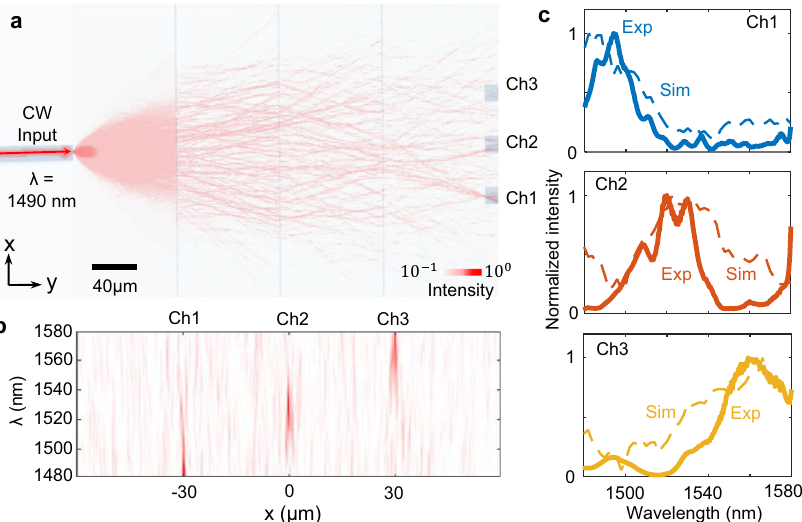
Fig. 4 Dispersion engineered three-layer metasystem for wavelength identi fi cation. a The simulated in-plane light distribution is superimposed on the optical image of a fabricated device. With an input wavelength of 1490 nm, light paths merge near the position of channel 1 on the output plane. b Measured (solid lines) and simulated (dashed lines) spectra at three output ports. c Simulated optical intensity distributions on the output plane. Three waveguide output ports (Ch1, Ch2 and Ch3) are centered at x = − 30, 0 and 30 µ m respectively.